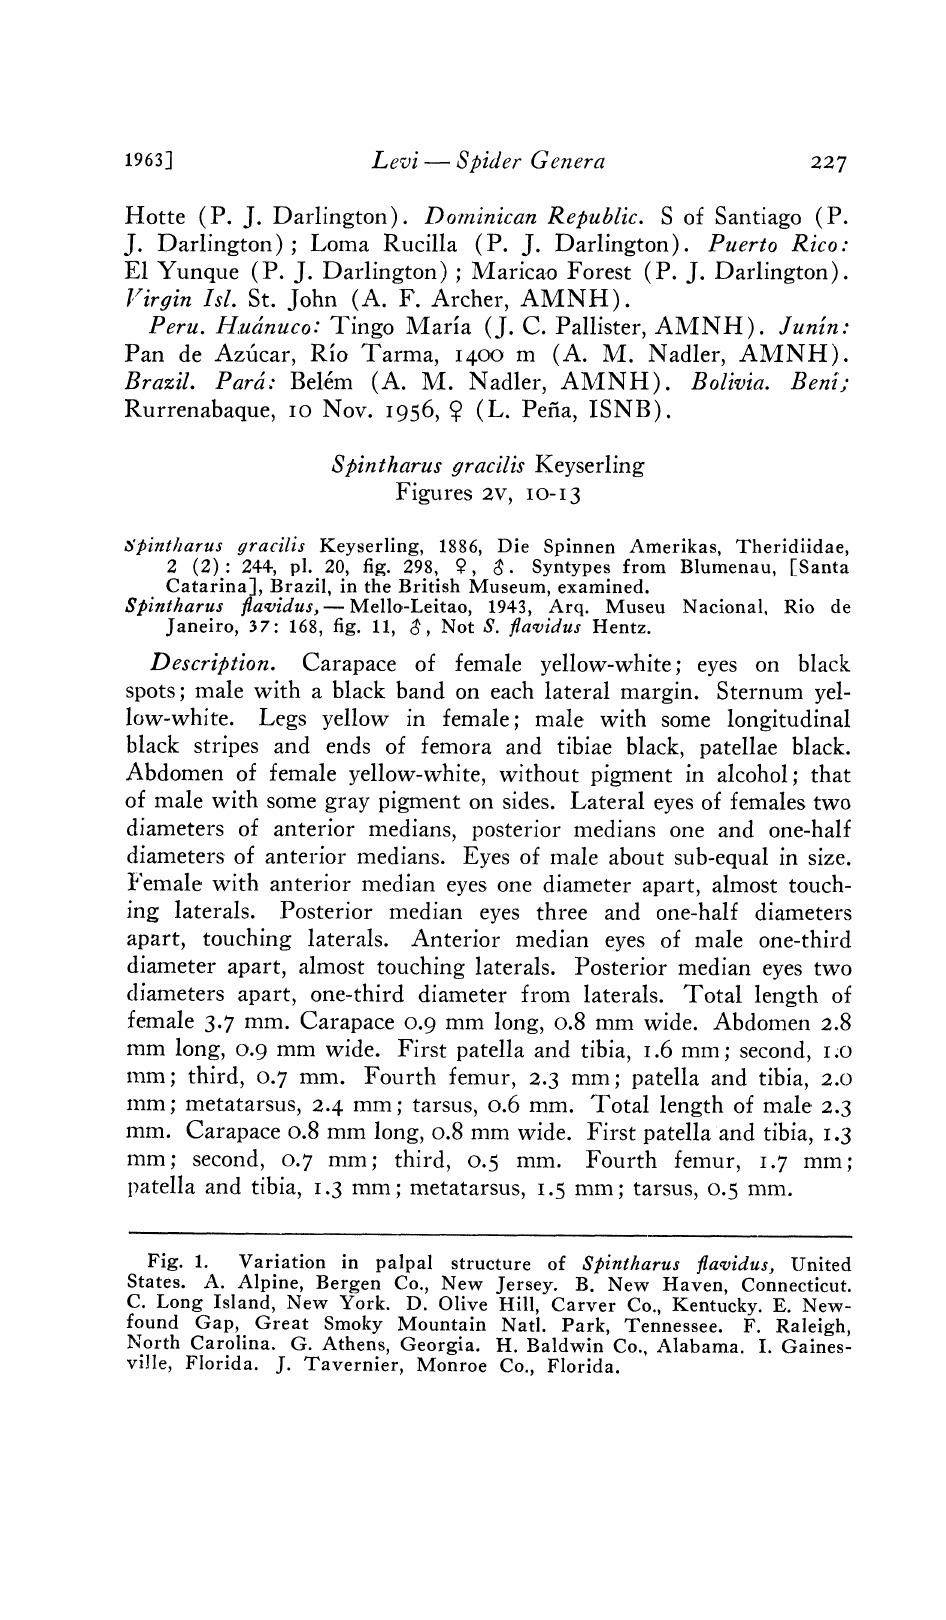
low-white. of male with some gray pigment on sides. Lateral eyes of females two diameters of anterior medians, posterior medians one and one-half diameters of anterior medians. Eyes of male about sub-equal in size. Female with anterior median eyes. one diameter apart, almost touch- ing laterals. Posterior median eyes three and one-half diameters apart, touching laterals. Anterior median eyes of male one-third diameter apart, almost touching laterals. Posterior median eyes two diameters apart, one-third diameter from laterals. Total length of female 3.7 mm. Carapace 0.9 mm long, 0.8 mm wide. Abdomen 2.8 mm long, 0.9 mm wide. First patella and tibia, 1.6 mm; second, I;O ram; third, 0.7 mm. Fourth femur, 2.3 mm; patella and tibia, 2.o mm; metatarsus, 2.4 ram; tarsus, 0.6 mm. Total length of male. 2.3 mm. Carapace 0.8 mm long, 0.8 mm wide. First patella and tibia, 1.3 mm; second, 0.7 mm; third, 0.5 mm.